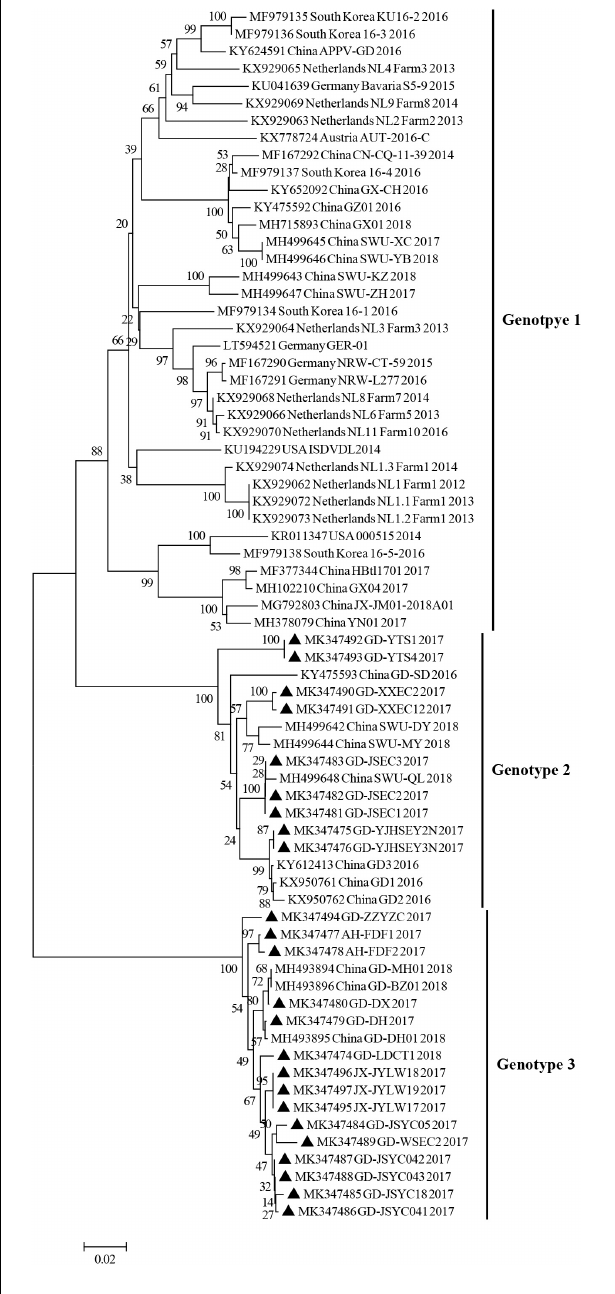
FIGURE 3 | Phylogenetic trees based on the partial sequences (633 bp) of the E2 gene. E2 gene sequences obtained in this study are marked with black triangles. Published sequences, including 46 E2 gene sequences, were downloaded from the GenBank database. MEGA 6.0 software was used to construct the NJ phylogenetic trees using a p-distance method with a bootstrap of 1,000